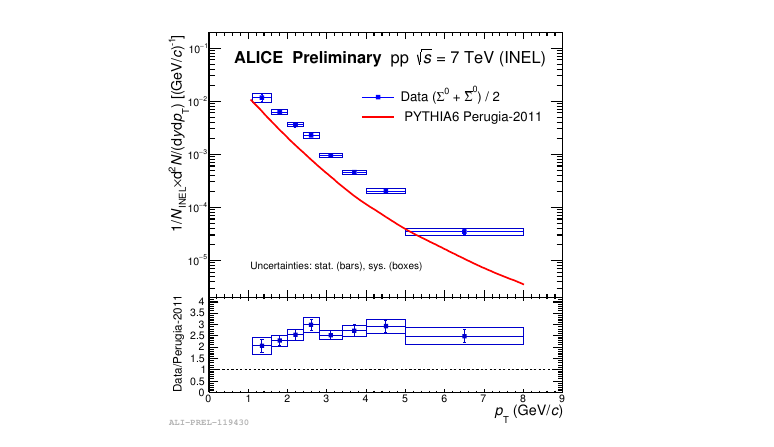
0 y < 0 . 5 is in the top ) / 2 in the rapidity range | | 0 ) / 2 yield to the simulated one integrated